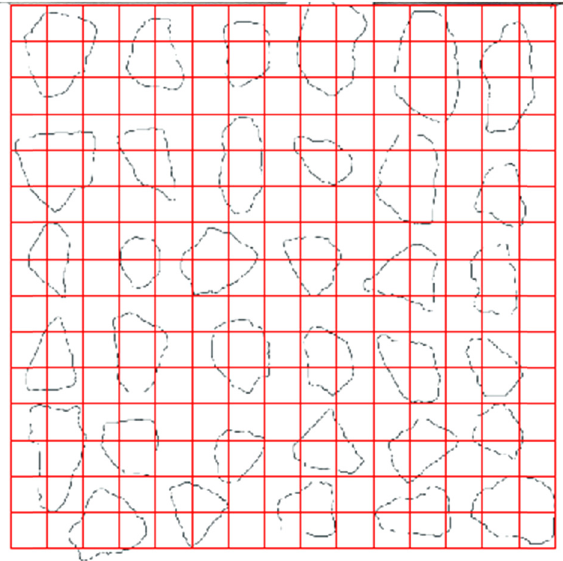
Figure 13: Double logarithmic fi tting of natural coarse aggregate ( a ) and Type II ( b ) recycled